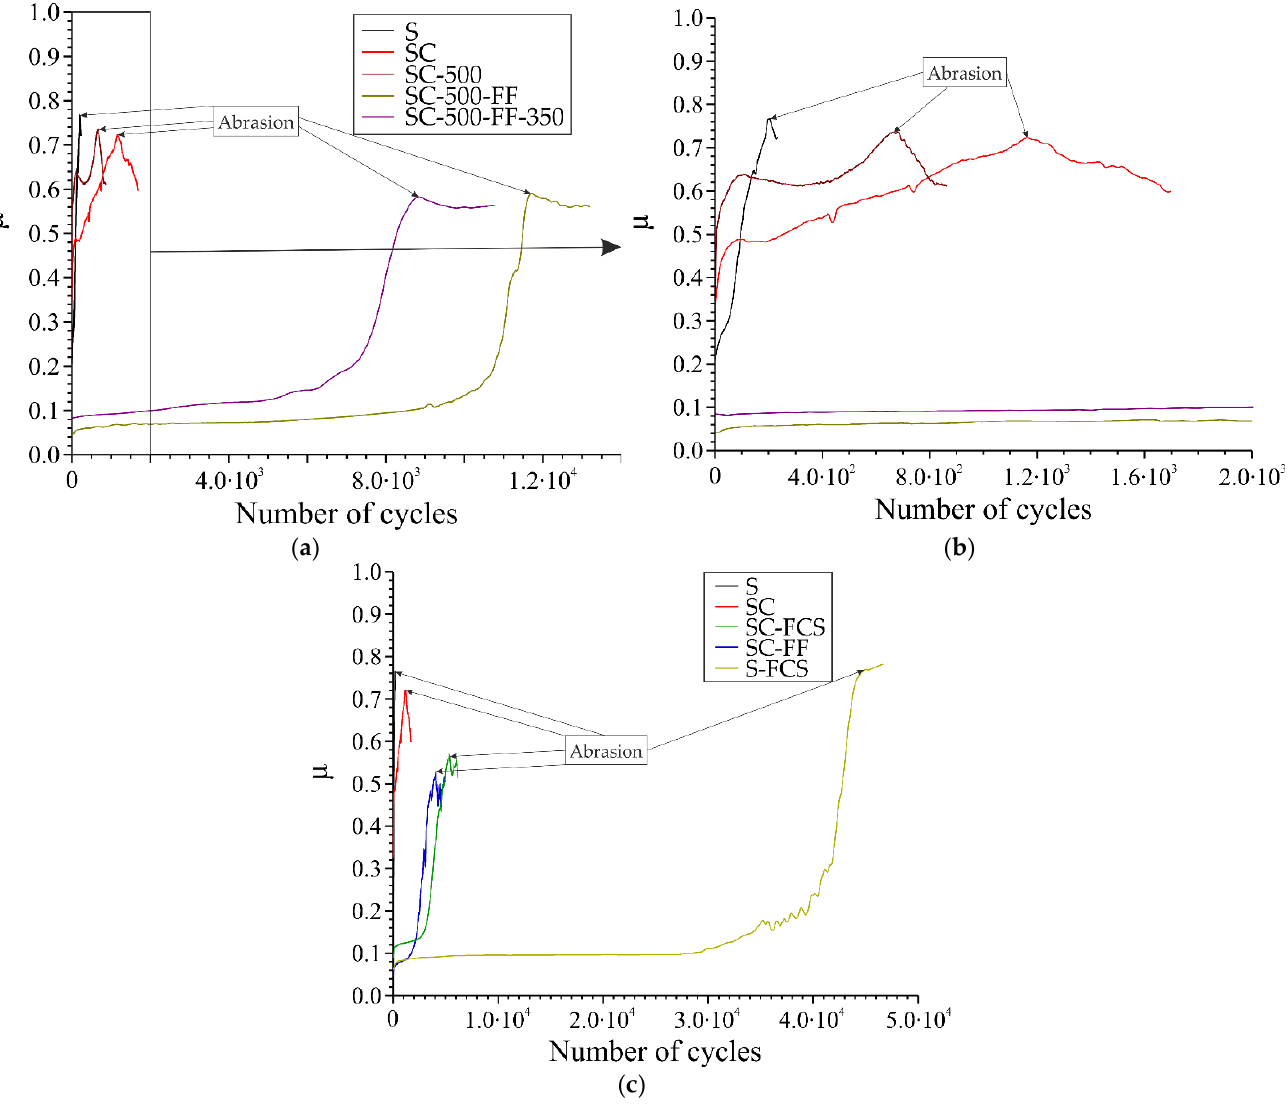
Figure 12. The results of tribological tests (dependence of friction coefficient on number of cycles) for the samples at various stages of processing ( a , b ) and at different types of SPTFE deposition ( c ). Samples S and SC are shown for comparison. Table 5. Tribological tests of the specimens with different types of